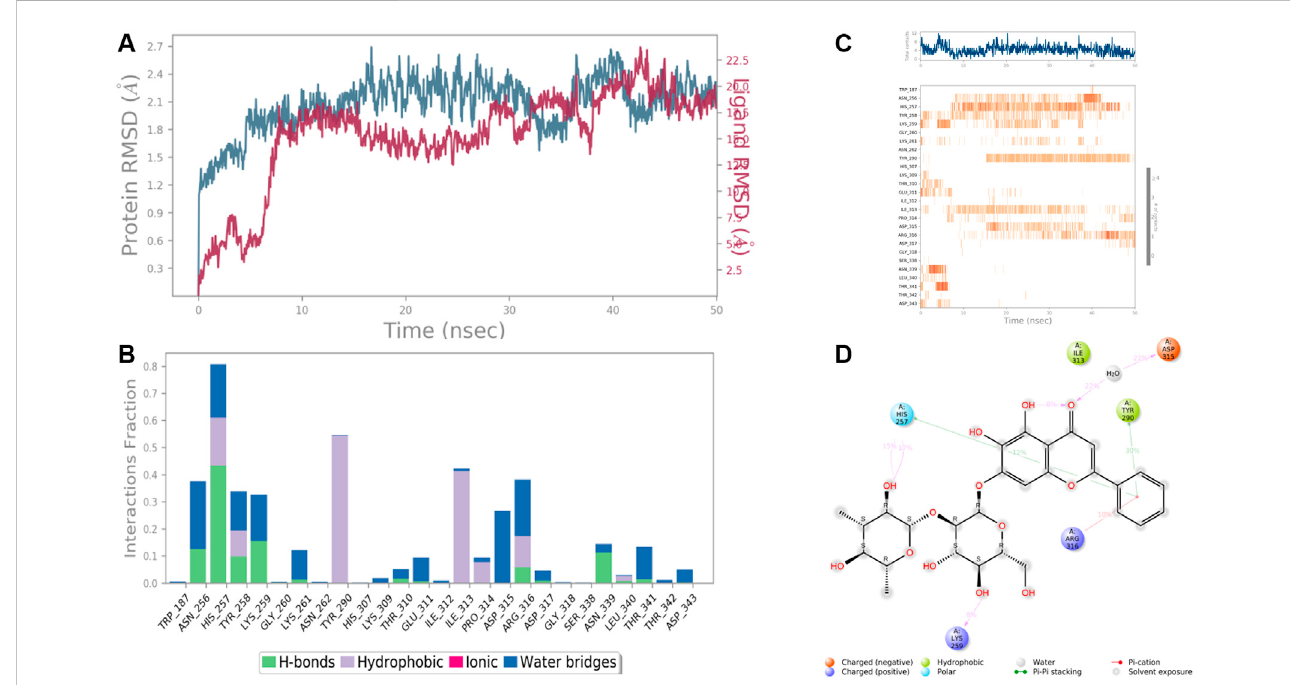
FIGURE 9 RMSD plot of the protein-ligand complex (PDB ID: 3ELB) (A) , Protein-ligand contacts (B) , stacked bar plot of the fraction of time of the interactions (C) , and Ligand- Protein contacts (D) of analogue Baicalein 7-O-diglucoside for 50 ns of simulation